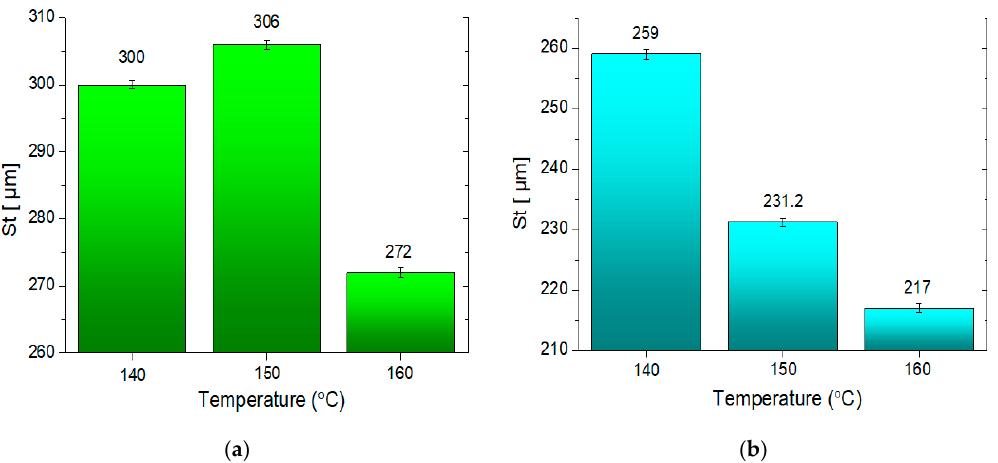
Figure 10. The total height (St = Sp + Sv) values of the mineral–asphalt mixtures: ( a ) WC-1; ( b ) WC-2.